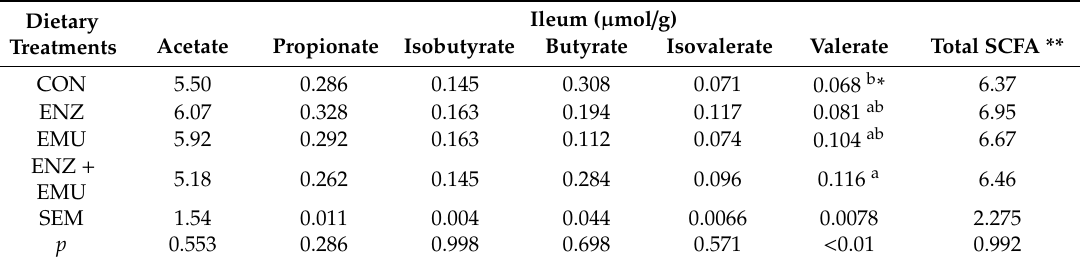
Table 6. Total short-chain fatty acid (SCFA) concentration in ileum digesta in birds fed control (CON), control supplemented with xylanase (XYL), control supplemented with an emulsifier (EMU), and control diet supplemented with xylanase and emulsifier XYL + EMU.